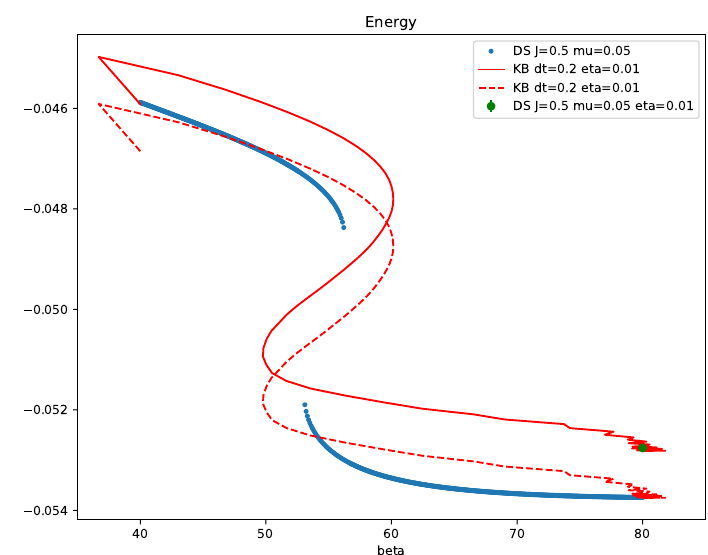
Figure 8 . The comparison between E ( β ) in equilibrium(blue points) and the real-time evolution of the system as it cools down (solid red line). The bath parameters are η = 0 . 01 , β initial linear ramp of the red curve occurs because we switch on the coupling with the bath linearly in time. The dashed red line is the same as the solid line but shifted to match the final energy on the phase diagram. The green dot shows the equilibrium value of the system+bath